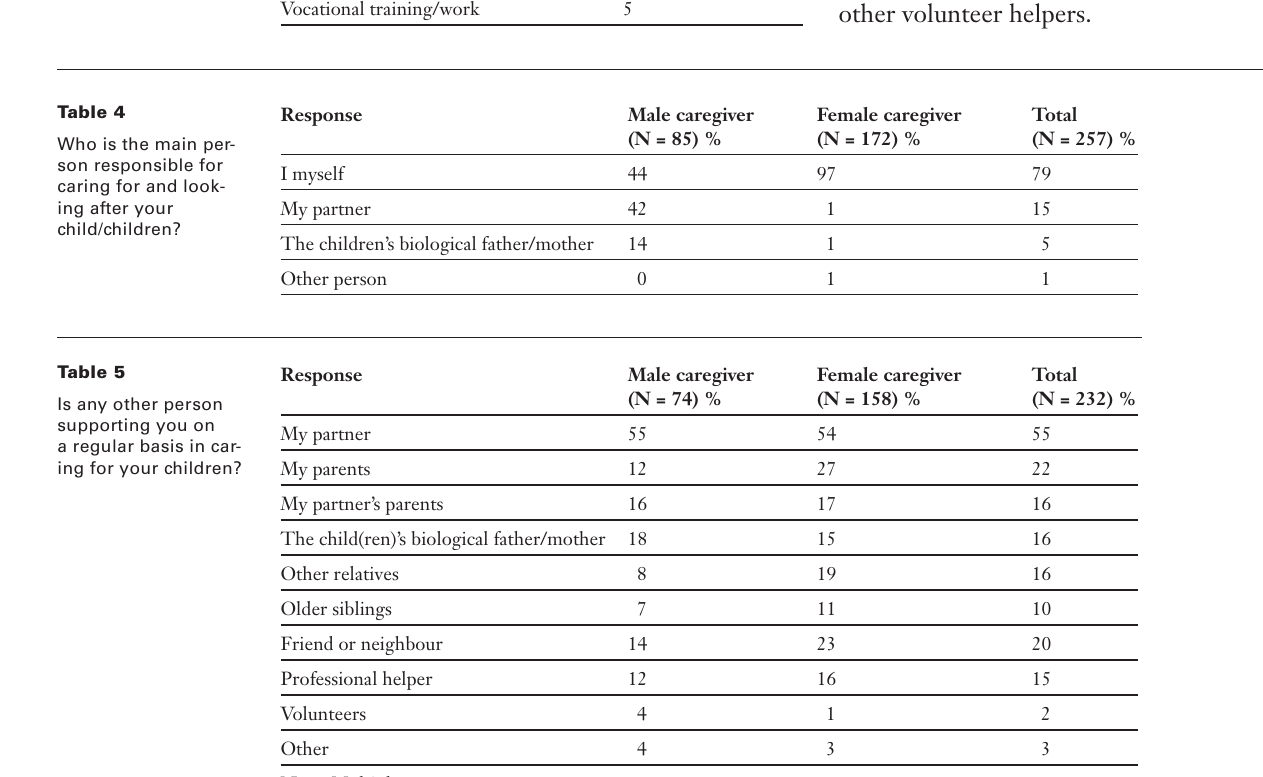
Is any other person supporting you on a regular basis in car- ing for your